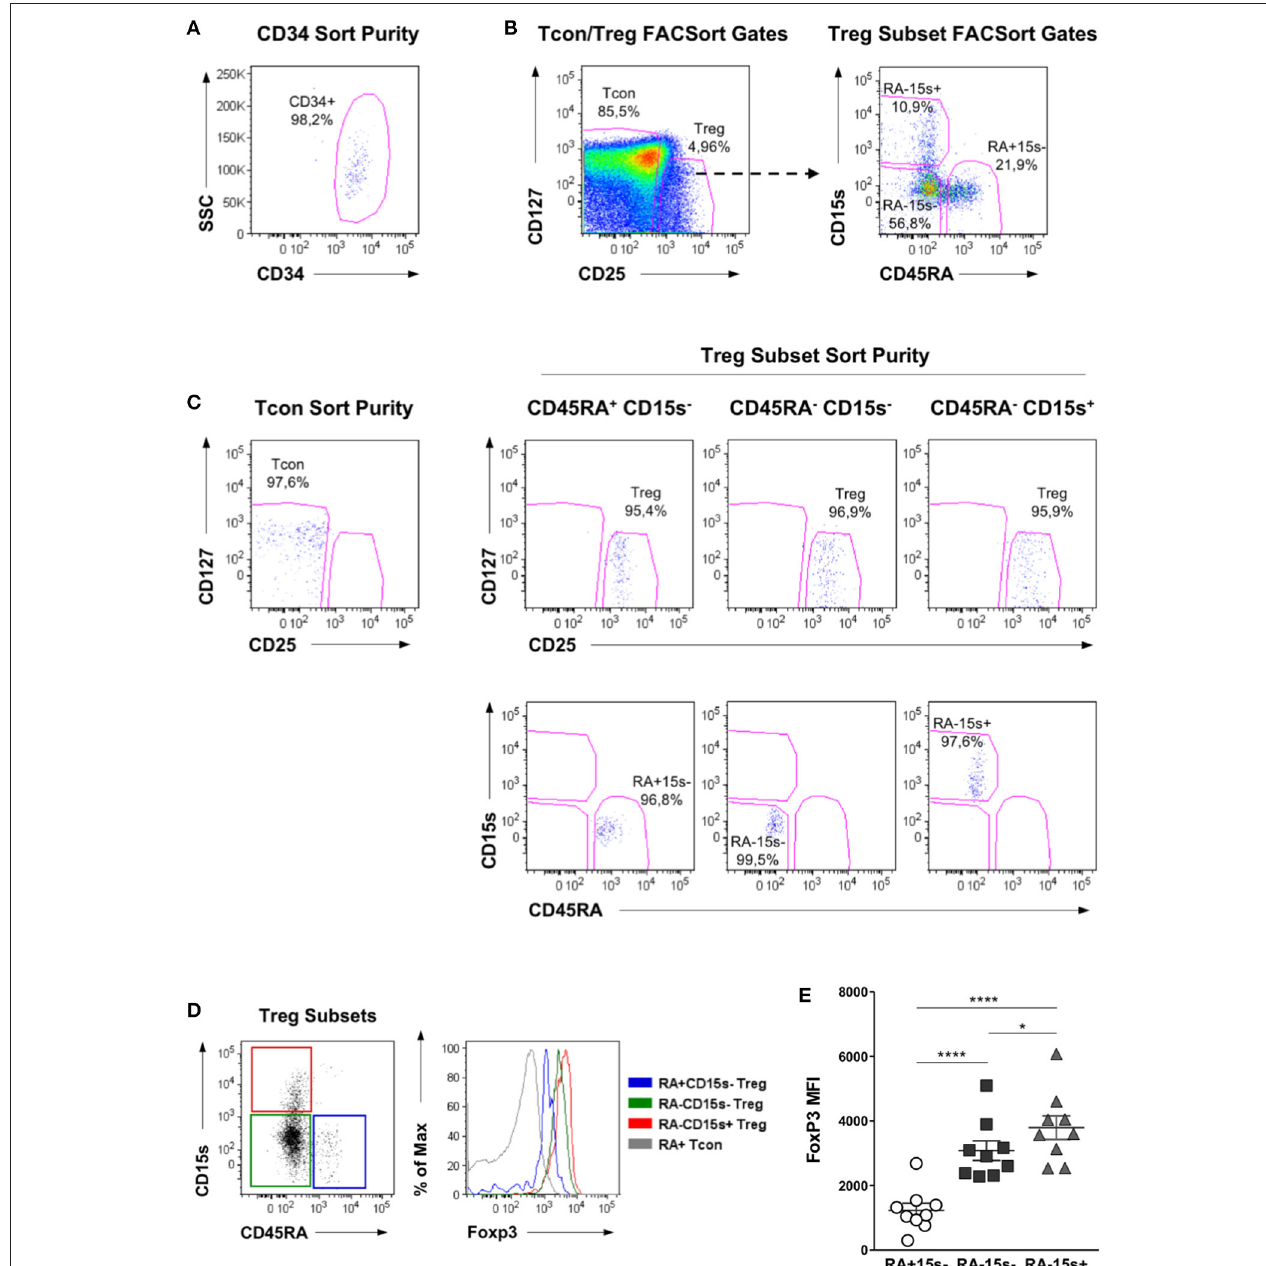
FIGURE 1 | Flow cytometry analysis and purification strategy of Treg, Tcon, and CD34 cell populations. (A) Purity of CD34 + cells after FACSorting. Representative dot plot showing the frequency of CD34 + cells within a live cell gate, as determined by FSC and SSC analysis. (B) Representative dot plots showing the gating strategy for the isolation of Treg and Tcon cells by FACSort. Firstly, FSC and SSC analysis was used to identify lymphocytes and to exclude doublets. Treg cells were isolated as CD3 + CD4 + CD25 Bright CD127 Low and Tcon as CD3 + CD4 + CD25 Low cells. Treg were further gated into CD45RA + CD15s − (naïve Treg), CD45RA − CD15s − (non-suppressive Treg-like cells), and CD45RA − CD15s + (eTreg). (C) Representative dot plots showing the purity obtained for each T cell population after FACSort. (D) FoxP3 expression levels within CD45RA/CD15s Treg subpopulations, as well as within naïve Tcon cells. A representative overlay of Foxp3 expression within these T cell populations is shown. (E) Median Fluorescence Intensity (MFI) of FoxP3 within Treg subpopulations for all individuals analyzed. Asterisks denote statistically significant differences between groups (* p = 0.01–0.05; **** p < 0.0001). ( Figure 1B ) and purity ( Figure 1C ) of each subpopulation are CD45RA − CD15s + (eTreg), as previously described (6). shown. These purified cell populations were used for subsequent The mean purity of the isolated populations was > 95%. methylation Representative dot plots illustrating the FACSort gating strategy